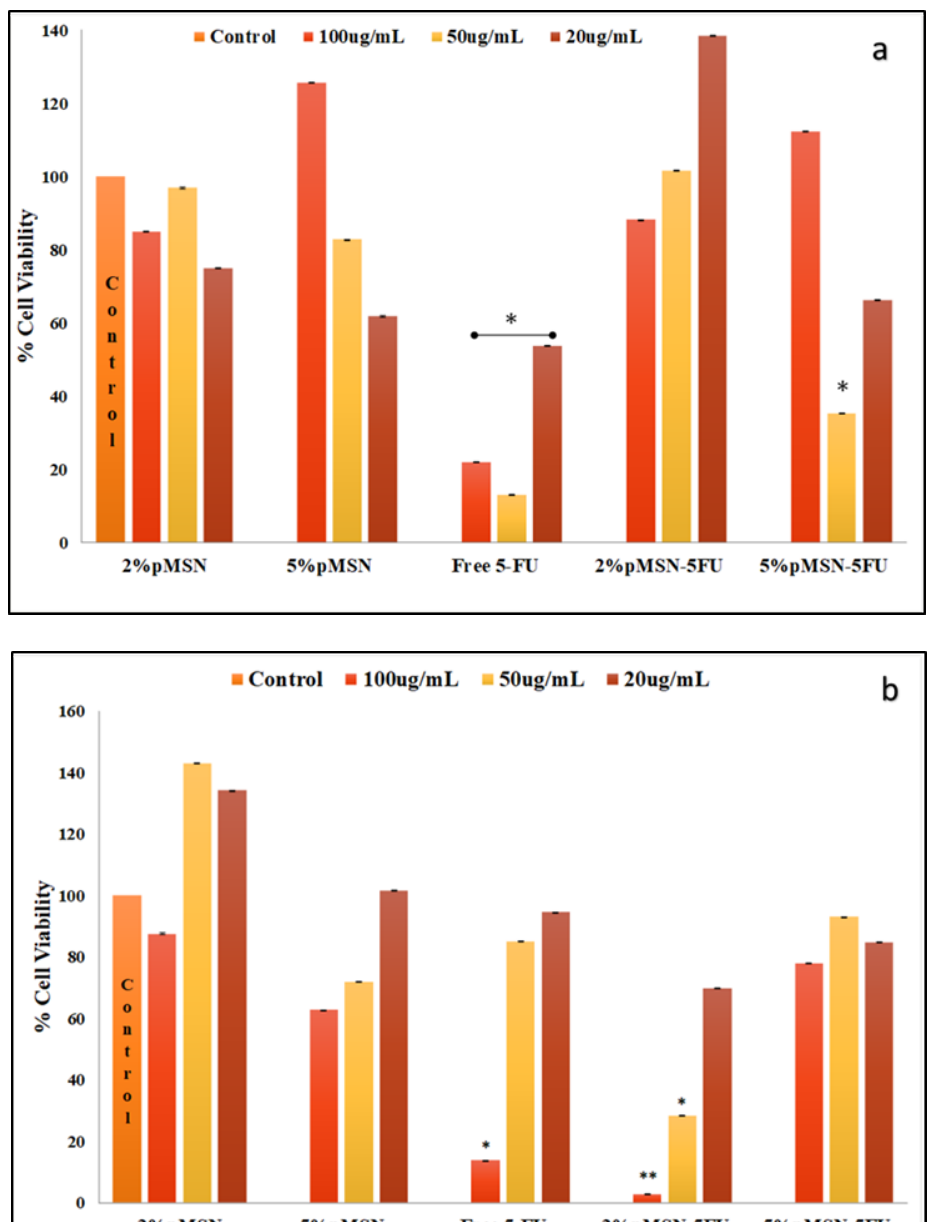
Figure 6. (a) MTT and (b) SRB cytotoxicity assay of f-MSNs and 5-FU-loaded MSNs administered at various concentrations (20, 50, and 100 μg/ mL) in Caco-2 cells . Data is represented as mean ± SD ( n = 3). * p < 0.05 and ** p < 0.01 were considered statistically significant.